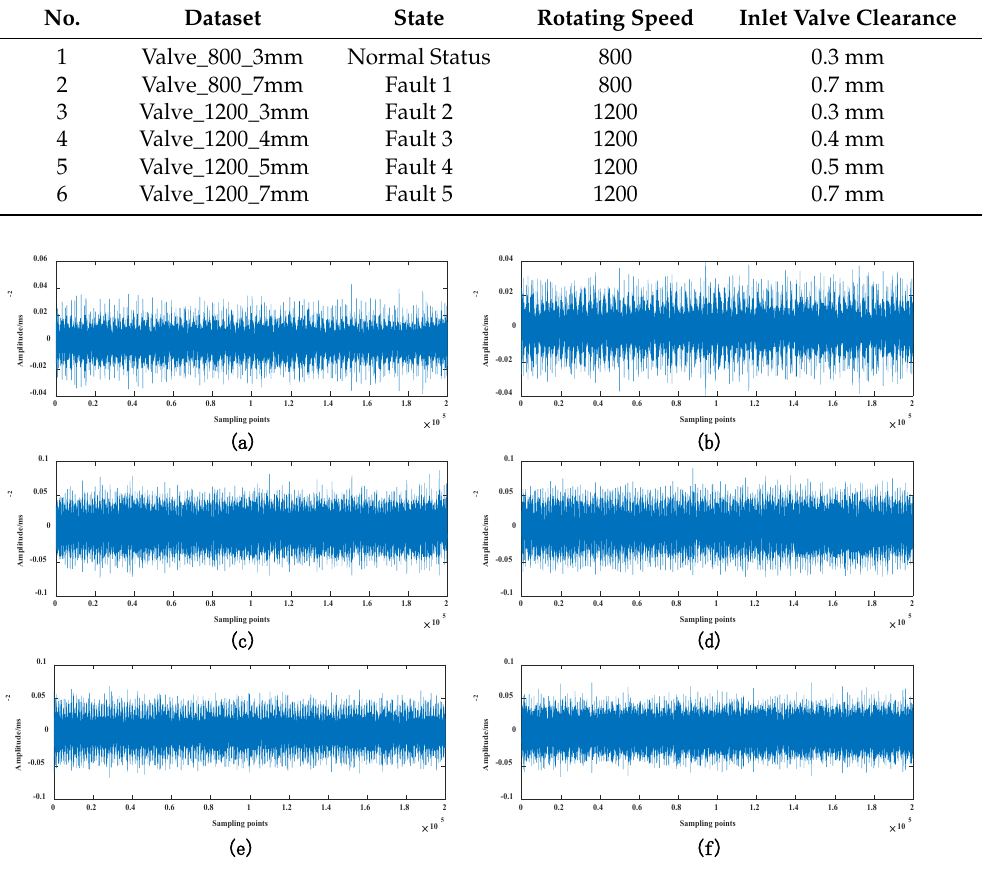
Figure 3. Experimental dataset: ( a ) Valve_800_3mm; ( b ) Valve_800_7mm; ( c ) Valve_1200_3mm; ( d ) Valve_1200_4mm; ( e ) Valve_1200_5mm; and ( f ) Valve_1200_7mm.